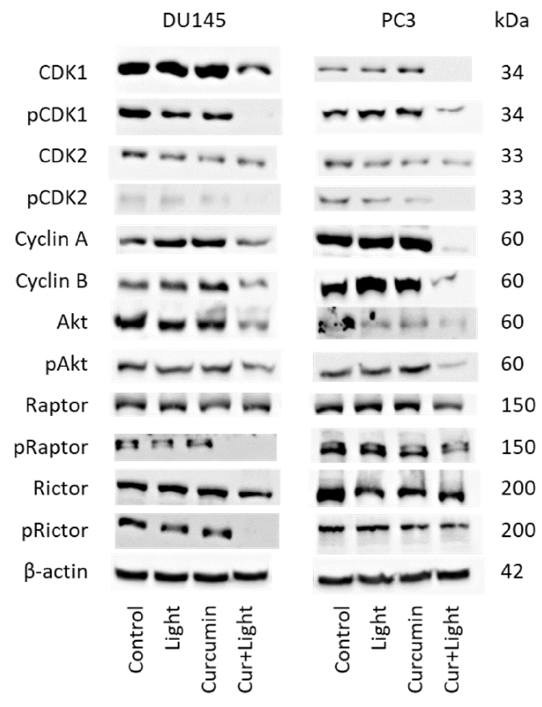
Figure 5. Protein expression profile of cell cycle regulating proteins in the presence of visible light (5 min at 1.65 J/cm 2 ), curcumin (0.2 µ g/mL) and the combination of curcumin plus light (Cur + Light) on DU145 and PC3 cells. Controls remained untreated. The protein isolation was carried out 24 h after treatment. ß-actin was used as the internal control. Each experiment was repeated 3 times. Data from one representative experiment is shown.